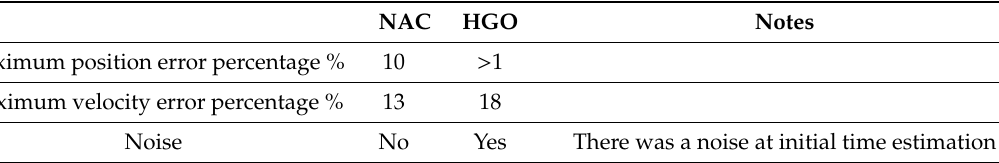
Figure 6. The estimated sprung mass velocity and time derivative of the output filter. Table 3. Control performance comparative study.